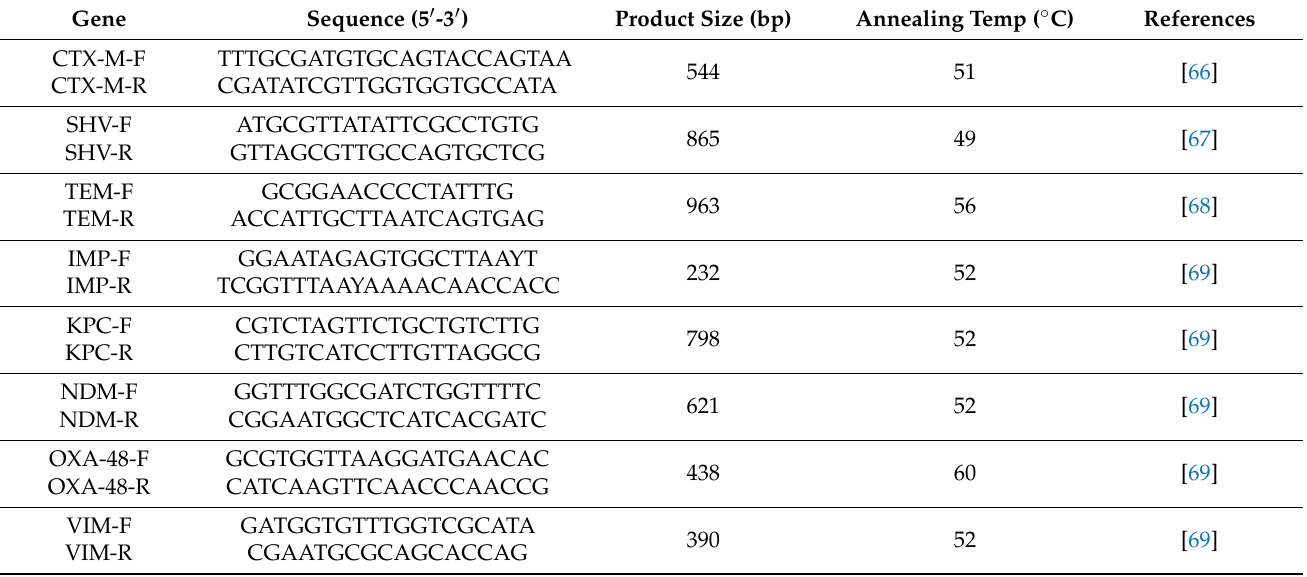
Table 8. Sequences, annealing temperature, and expected product sizes of primer pairs targeting the specified β -lactamase